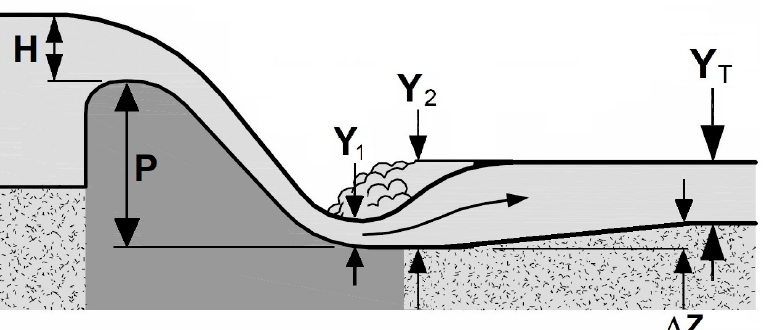
Figure 2. Schematic diagram of the hydraulic jump at the toe of a low-head dam, showing the initial depth entering the jump, Y 1 , and the downstream conjugate depth, Y 2 , provided by the existing tailwater condition (adapted from [7]).